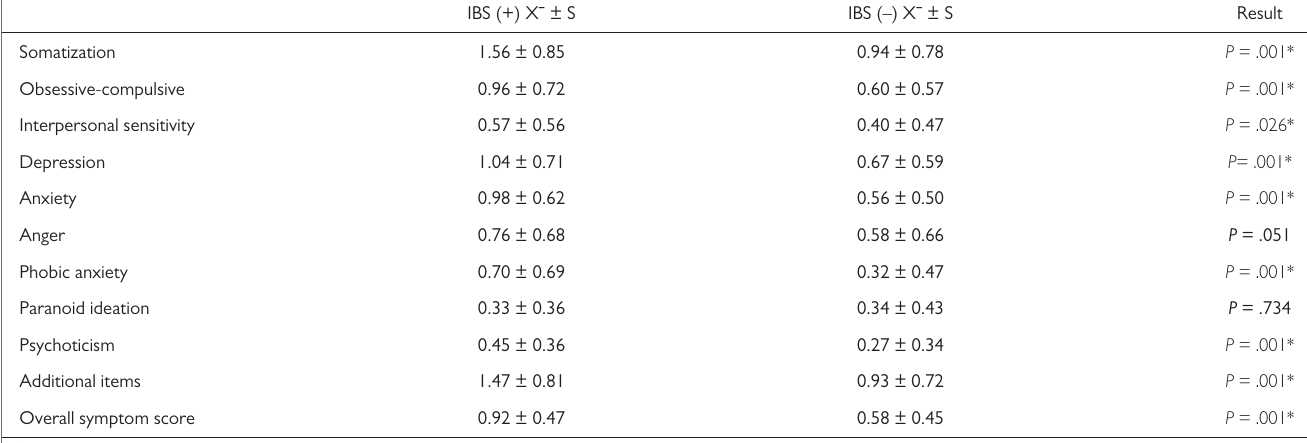
Table 4. Comparison of Patients with and without IBS According to Symptom Check List Revised (SCL90-R) Scale